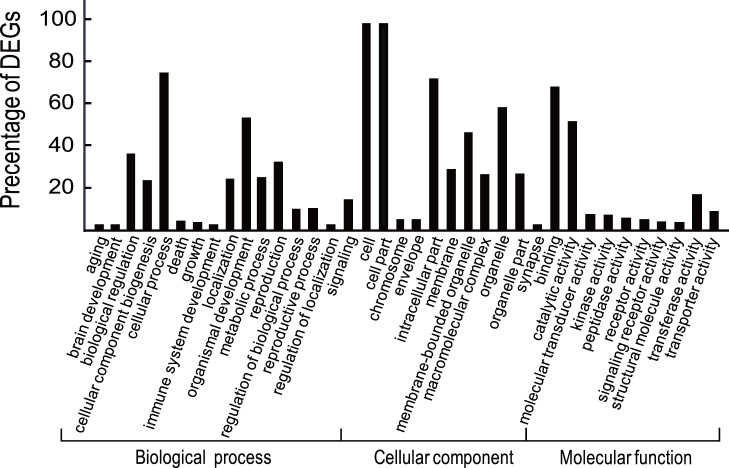
Gene Ontology classification of DEGs in mRJM.The results are summarized in three main categories: biological process, cellular component and molecular function. TheY-axis indicates the precentage of DEGs in a category. The X-axis indicates category.